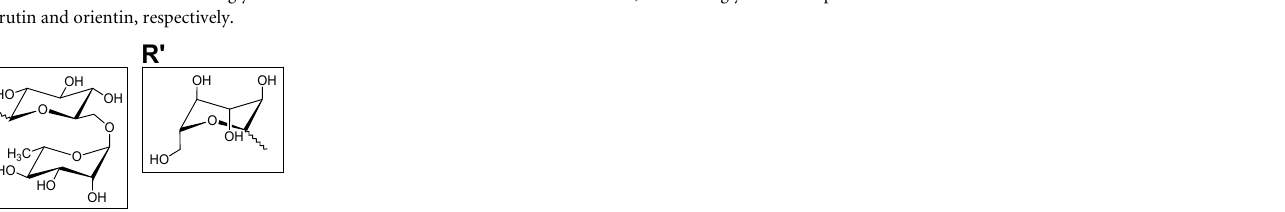
sentation of the color shift from pale yellow to dark yellow after rutin chelation of Al 3 + ions. The spectra